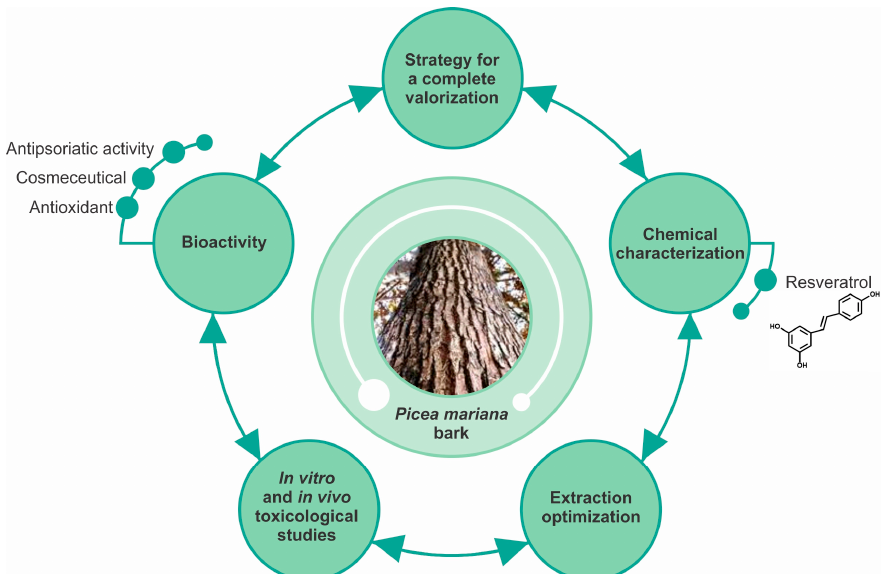
Figure 3. Strategy to valorize the Picea mariana bark extracts. The valorization of the bark extract from P. mariana involves several stages, starting from the chemical characterization and the identification of bioactive polyphenols, notably trans-resveratrol. The optimization of the extraction is crucial for guaranteeing reproducible yields of bioactive compounds. The most suitable parameters allowing polyphenolic extraction were determined to be 80 °C and a ratio of bark/water of 50 mg/mL especially for obtaining low-molecular-weight polyphenols. The toxicological studies are important for determining the safe concentrations for extracts both in vitro and in vivo. Extracts demonstrated to have potential activity as antiaging, antioxidant, and antipsoriatic agents.